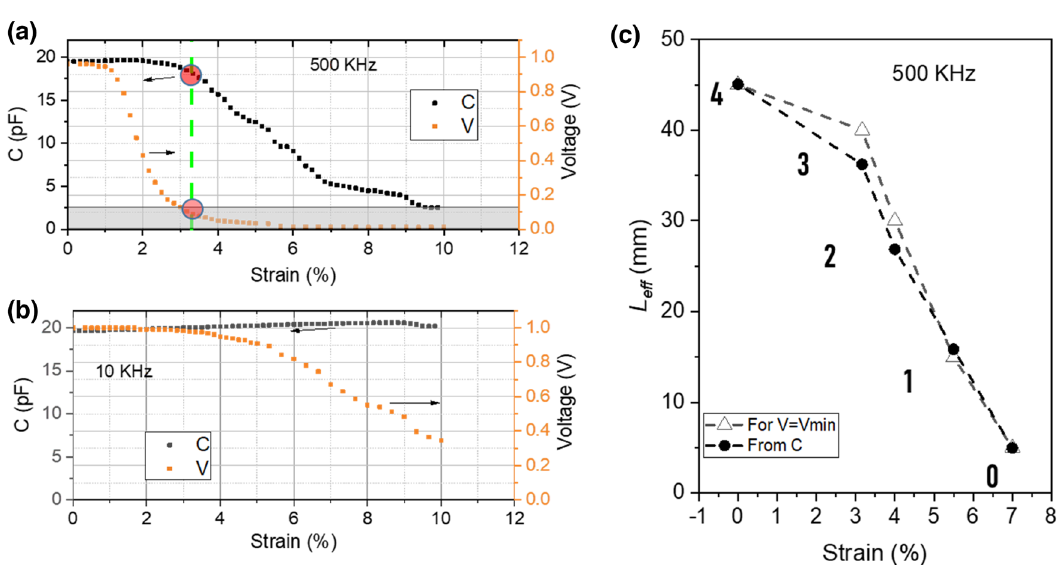
Figure 3. Relationship between sensor capacitance and voltage dissipation: ( a , b ) influence of voltage dissipation on the measured capacitance at high (500 kHz) and low (10 kHz) frequencies, respectively; the voltage is collected from the end of the sensor. ( c ) Effective length L eff versus strain, derived either from the capacitance measurements or voltage